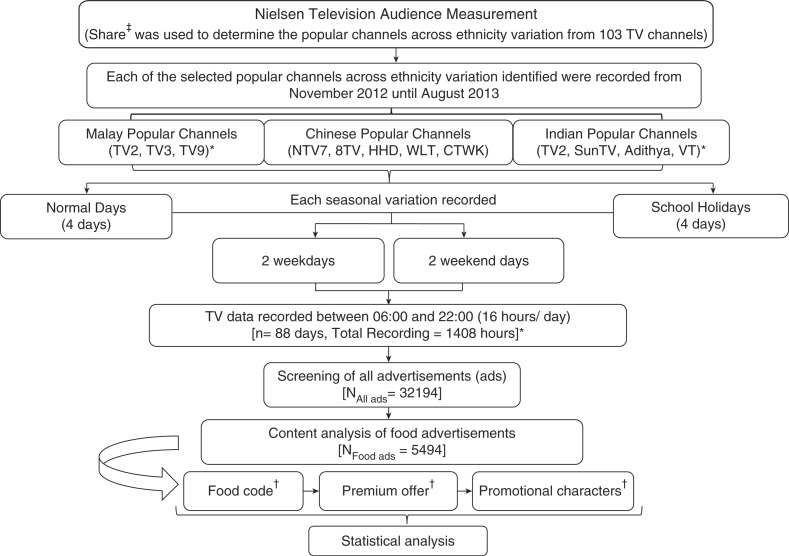
Flow chart of content analysis. For ethnic-specific popular channels, three popular channels were for Malay whilst five popular channels were Chinese and four popular channels were Indian. *However, one TV channel was common to both Malay and Indian viewership. Hence, overall analysis was carried out based on only 11 channels. ‡Proportion of individuals’ viewership per channel compared to the total viewership for all channels for same time period. †Protocol developed based on previous international methodology for TV food advertising (26).